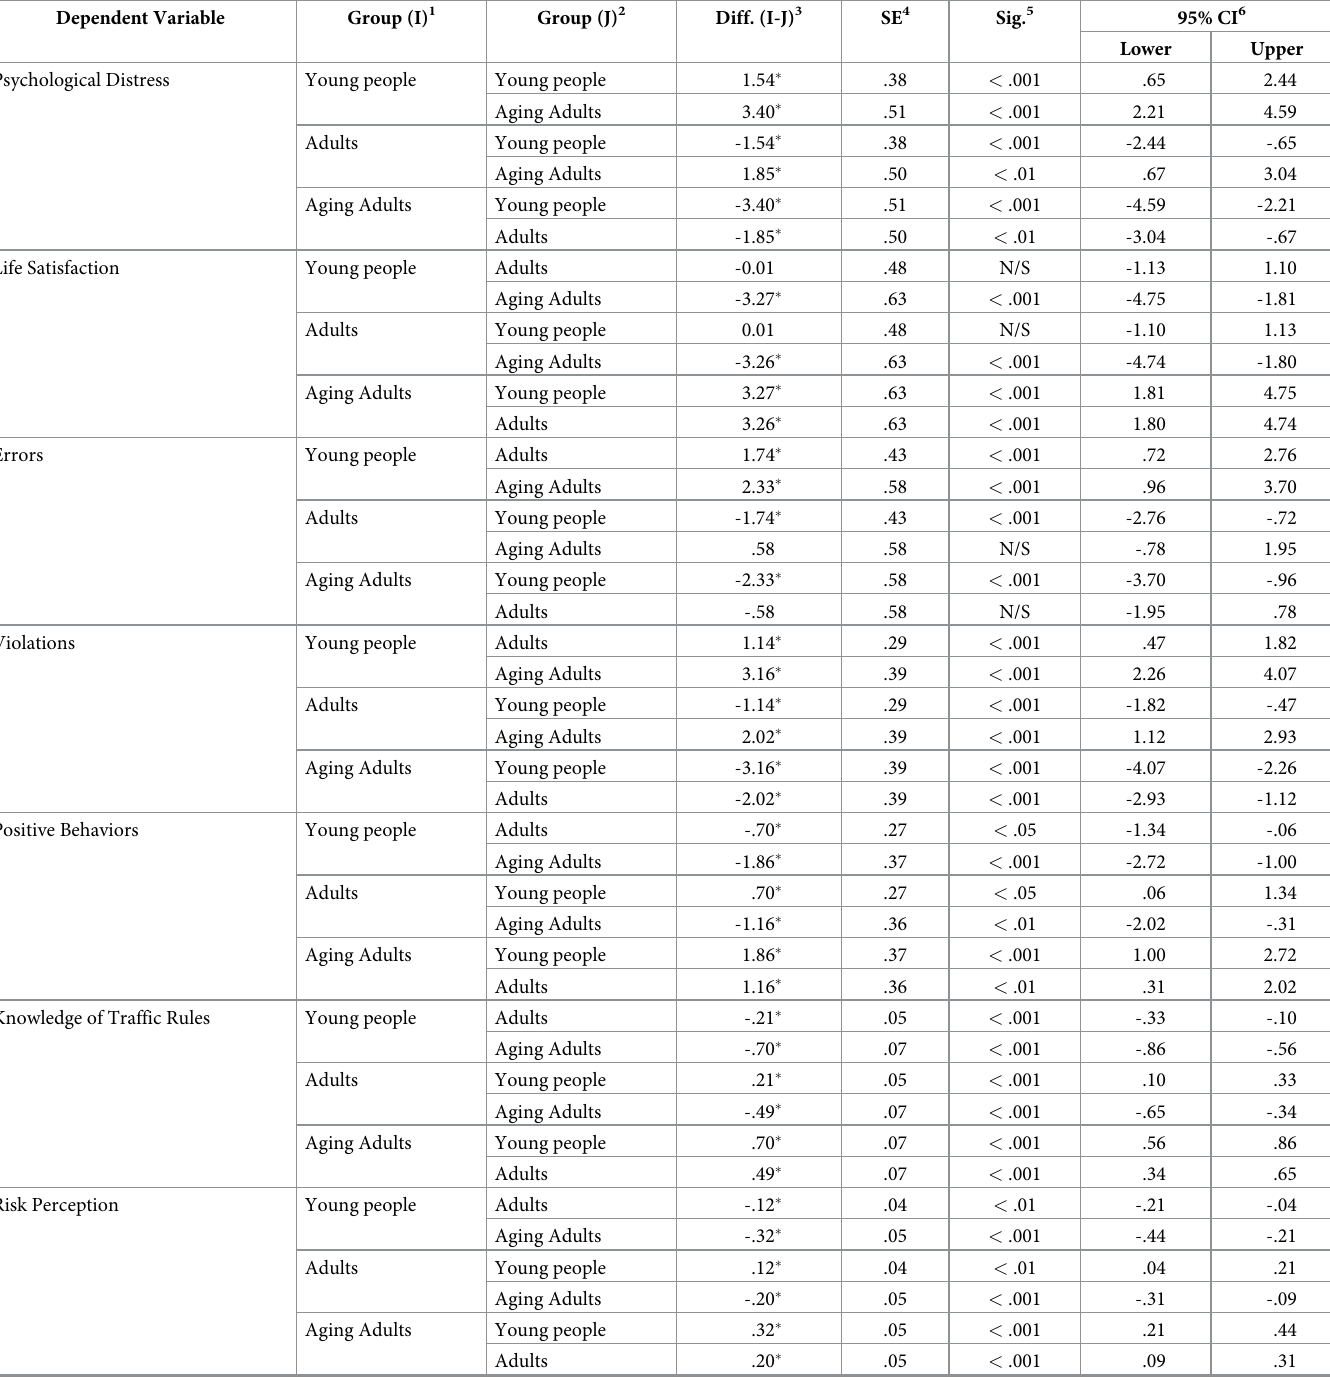
Table 4. HSD (Tukey) Post-Hoc tests for comparing age-based scores between pairs of groups. Dependent